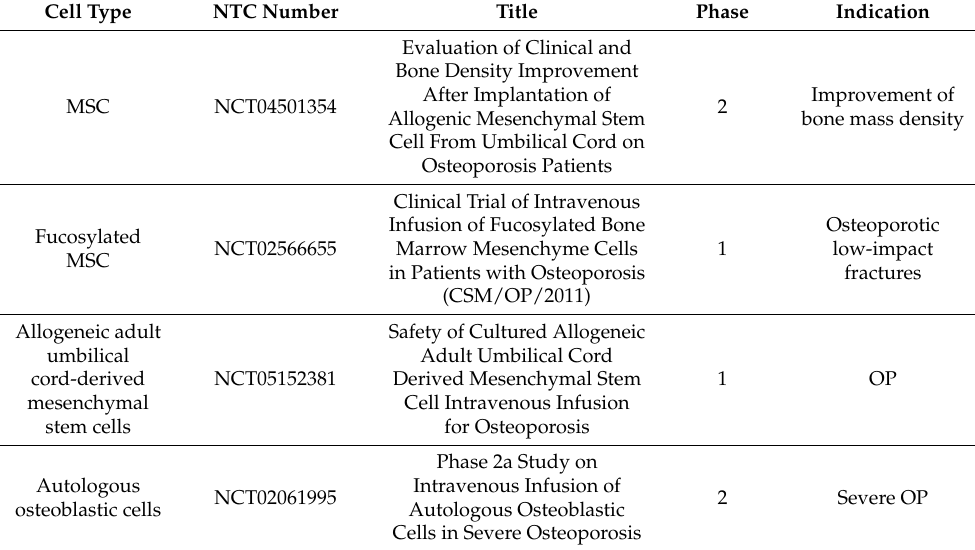
Table 2. Clinical trials with cell therapies for